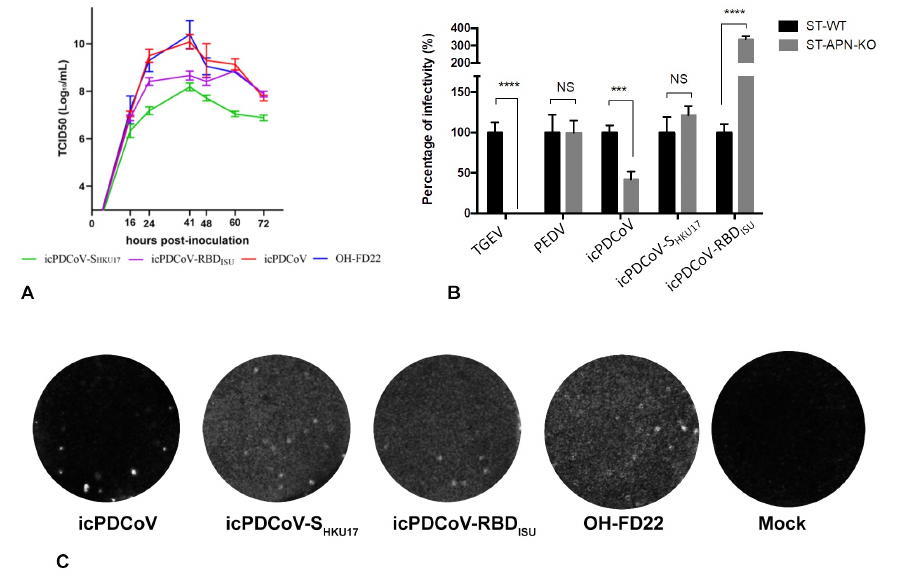
Figure 3. Characterization of the recombinant PDCoVs. ( A ) Multistep growth kinetics of the infec- tious clone-derived recombinant PDCoVs (icPDCoV, icPDCoV-RBD ISU , icPDCoV-S HKU17 ), and the parental PDCoV OH-FD22 strain. LLC-PK1 cells were inoculated with each virus at a MOI of 0.01. Supernatants were sampled at different time points and titrated for TCID 50. ( B ) The infectivity of the recombinant viruses in wildtype ST (ST-WT) cells and APN-knockout ST (ST-APN-KO) cells. TGEV and PEDV were used as APN-dependent and APN-independent controls, respectively. Mono- layer of cells infected with different viruses with MOI = 0.2. After removal of the inoculum, the cells were cultured for additional 8 h, fixed and stained for TGEV, PEDV, and PDCoV, respectively. Fluorescent focus units (FFU) were counted using a fluorescent microscope. Data are presented as the means ± SD. *** p < 0.005; **** p < 0.001; NS, no significance. ( C ) Plaques of recombinant PDCoVs in LLC-PK1 cells. Cells were fixed and stained at 96